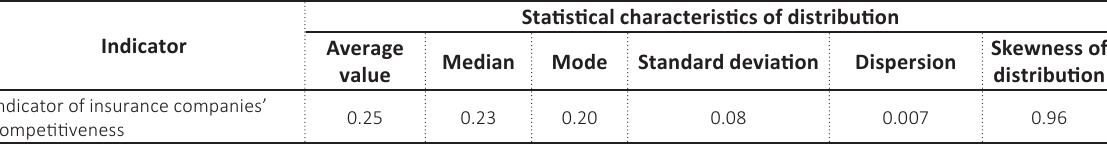
Table 2. Statistical characteristics of distribution of integrated indicator of insurance companies’ competitiveness on travel services market